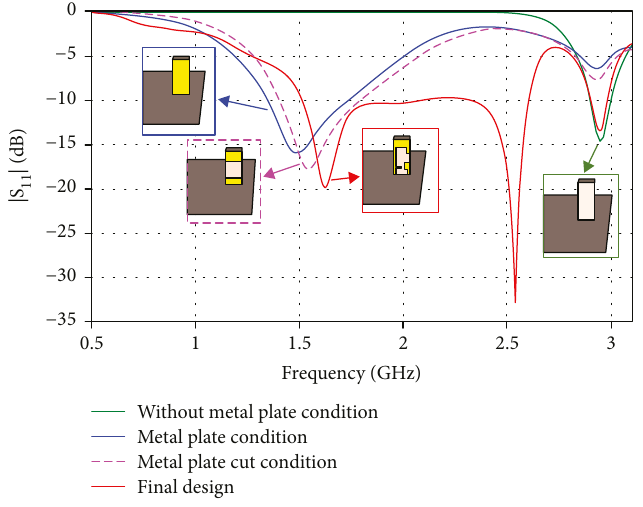
Without metal plate condition Metal plate condition Metal plate cut condition Final ∣ parameters for the four studied Figure 8: ∣ S 11